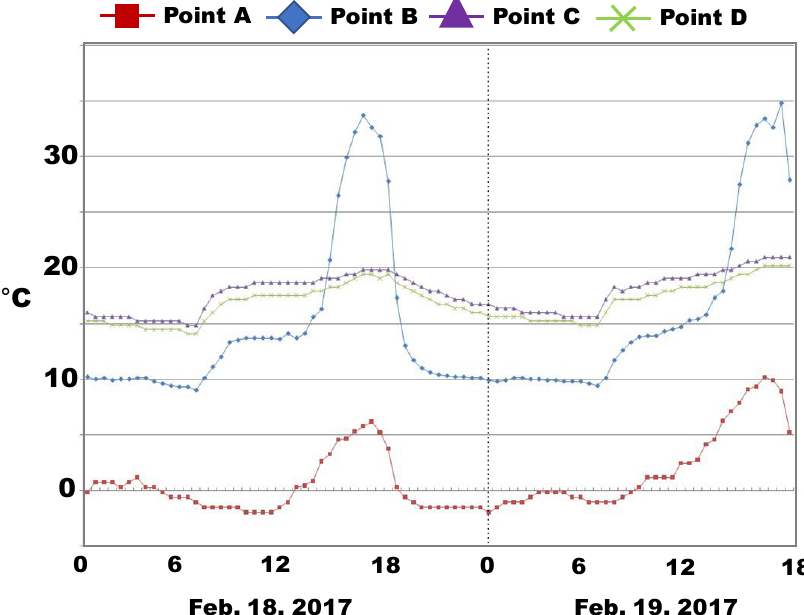
Figure 10. Measurement results at the 5th floor.